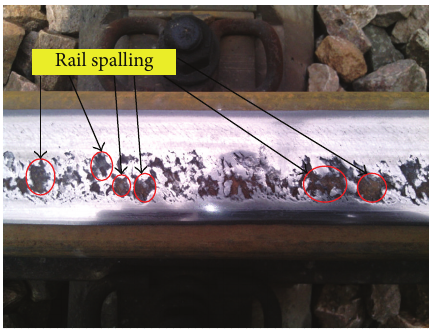
Figure 1: Spalling in rail surface.